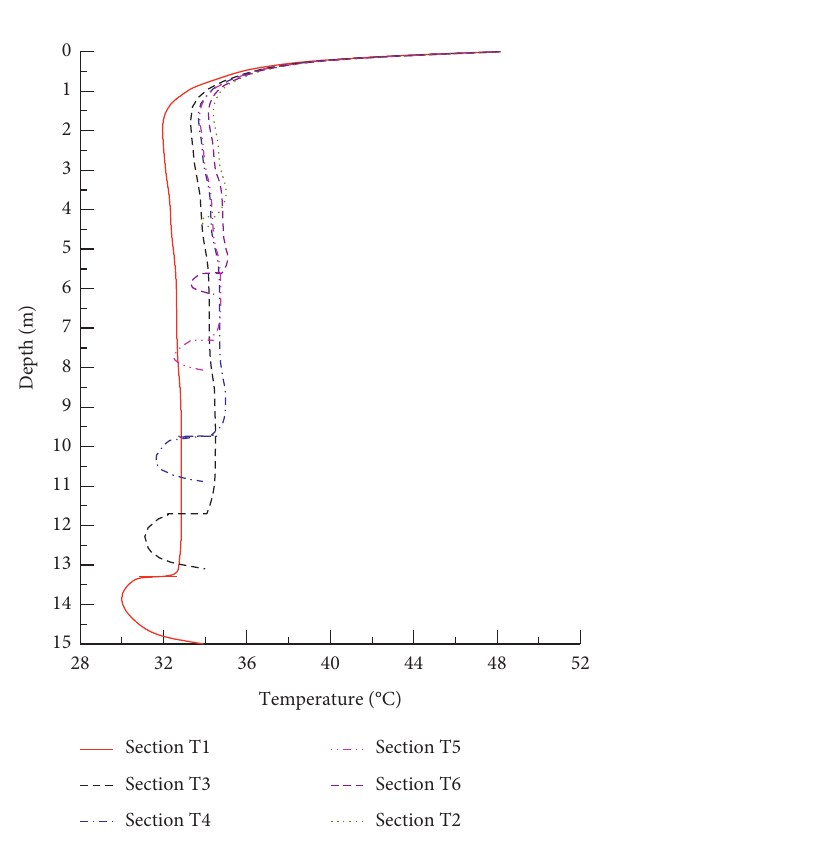
Figure 15: The predicted vertical temperature distributions along the depth of the girder at the six cross-sections on August 3, 2010, when the vertical temperature differences reached a maximum